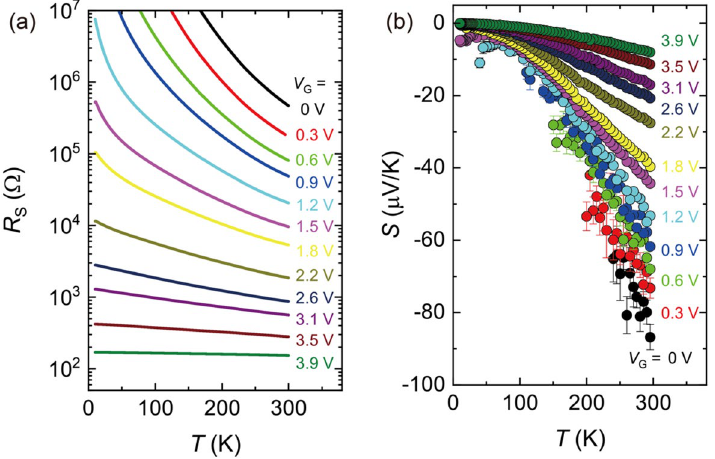
Figure 3. Gate induced transition from insulator to metal in WO 3 thin film. ( a ) Temperature T dependence of sheet resistance R s under gate bias. The values of R s are suppressed by the application of gate voltage V G . R